Question: Identify the chart type used in this figure.
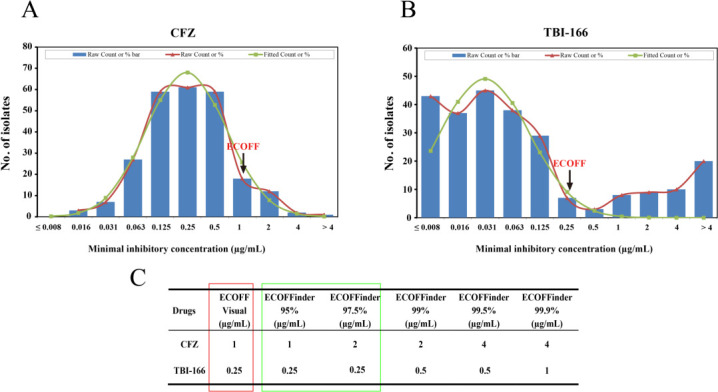
Answer: histogram